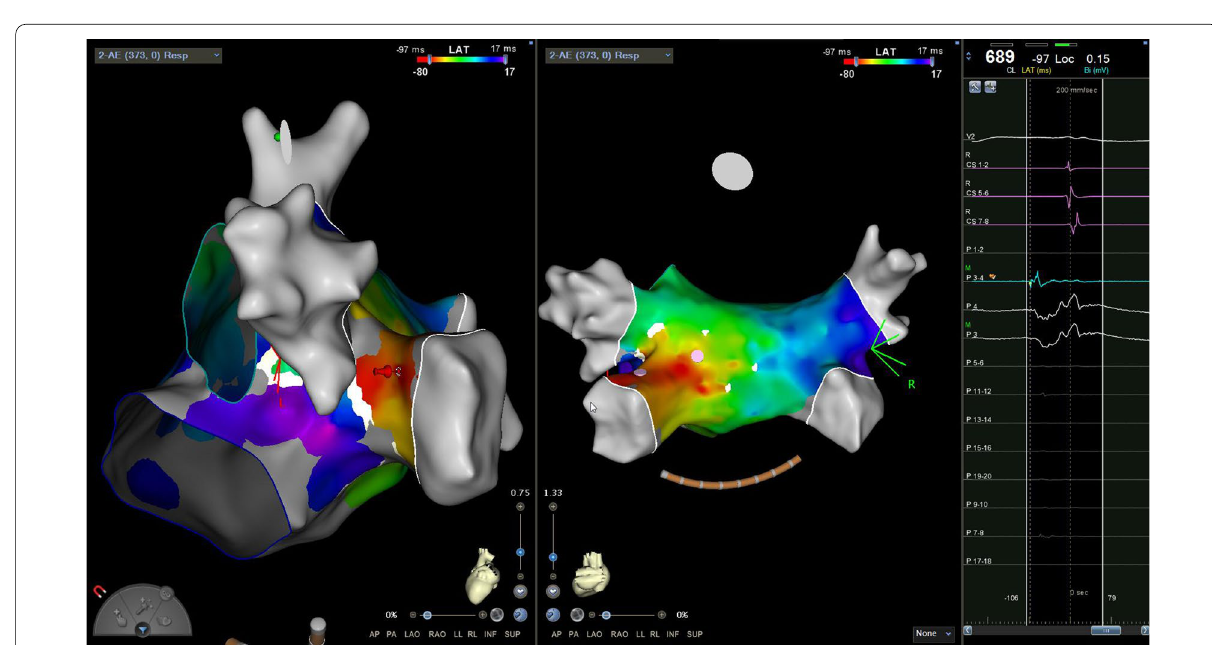
Fig. 4 The electrophysiological study performed in focal atrial tachycardia identified the region of earliest local activation in the lower left pulmonary vein (CARTO ©3D Mapping